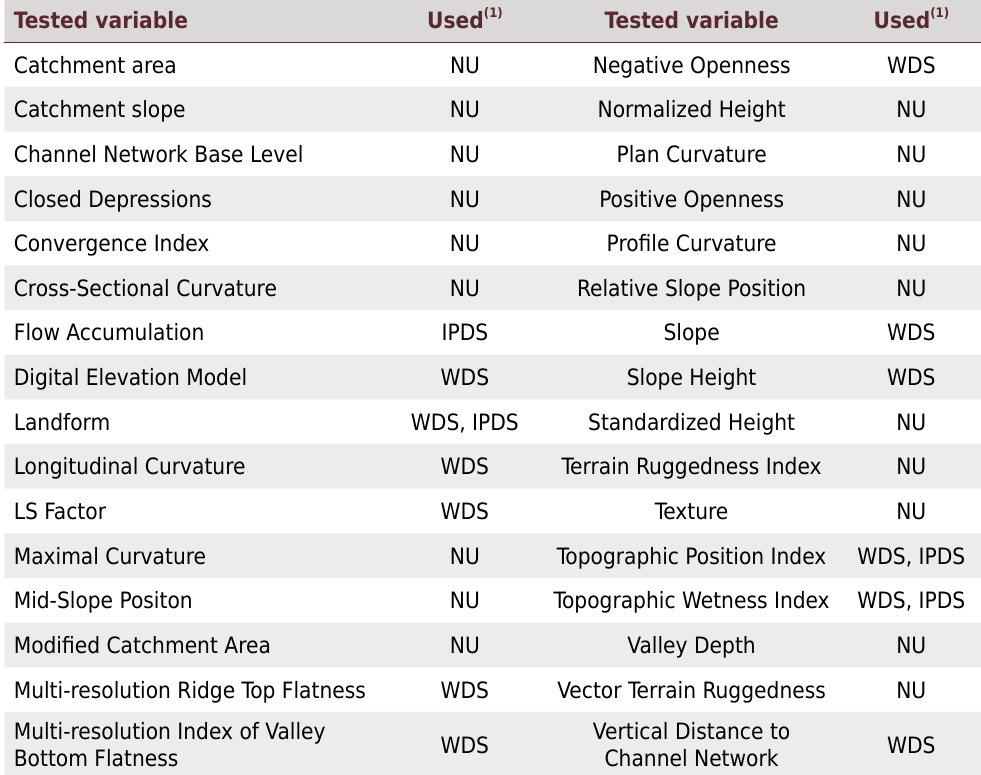
Table 3. Variables tested in the decision tree